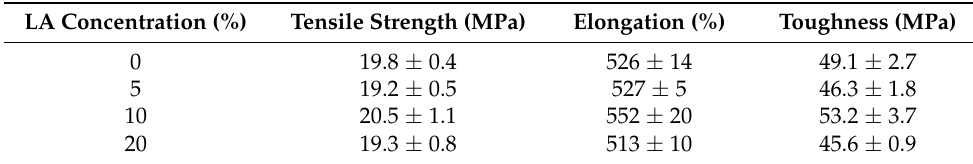
Table 3. Tensile properties of biochar as a function of LA concentration.